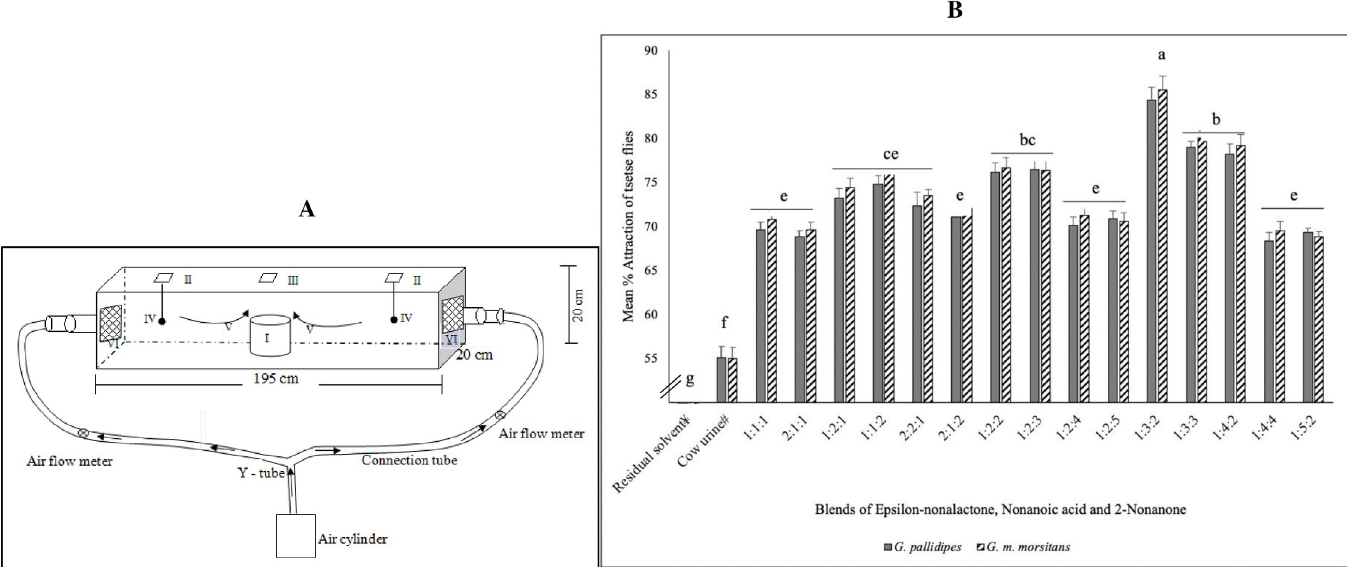
Fig 1. A: Schematic diagram of the wind tunnel employed for behavioral bioassay Insect release cage ( I ), windows for introducing test material dispensers ( II ), window for introducing insect release cage ( III ), test material dispenser ( IV ), air flow direction ( V ) and PVC gauze for keeping flies within the tunnel ( VI ). B: Wind-tunnel responses of G . pallidipes and G . m . morsitans to attractive blends in varying proportions. Means followed by the same letter are not significantly different ( p > 0.05, SNK post-hoc analyses).